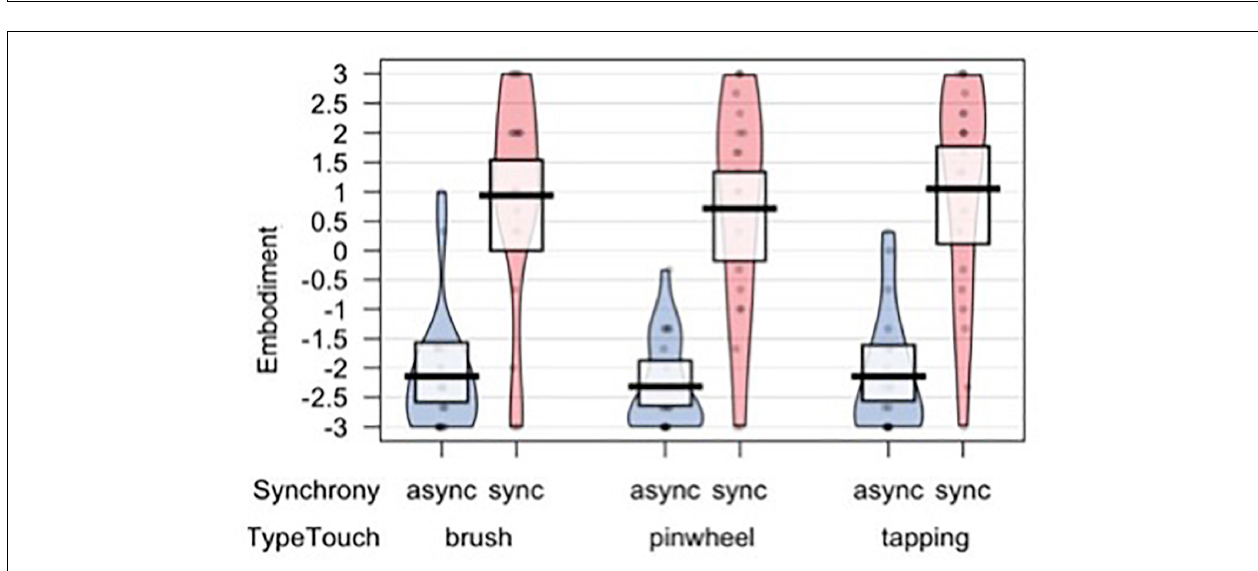
FIGURE 5 | Skin Conductance Levels (SCL) during tactile stimulations. Contrasts between different types of touch have been reported, showing that rubbing with a pinwheel produced an increased of SCL on the contrary of brush stroking and tapping.